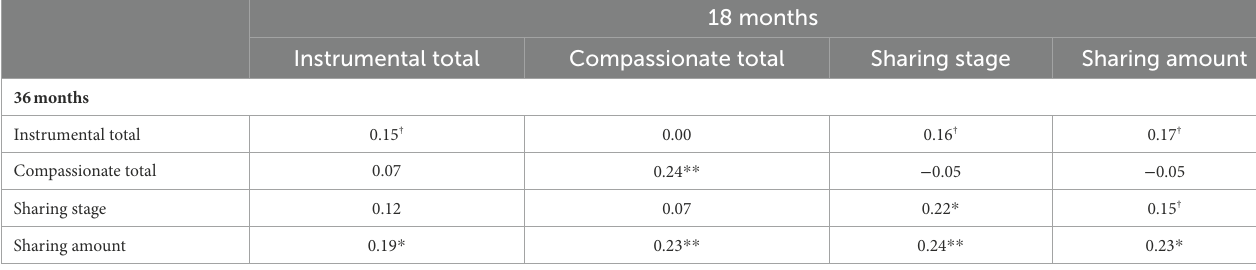
TABLE 4 Longitudinal links from 18 to 36 months, between different subtypes of prosocial behavior.